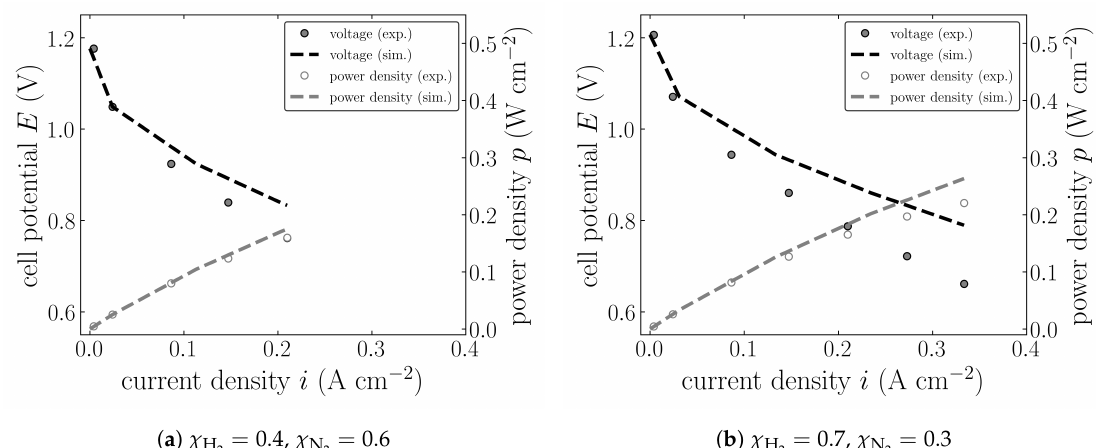
Figure 11. Comparison of the experimental and numerical data for the different inlet fuel compositions ( T fur = 750 ◦